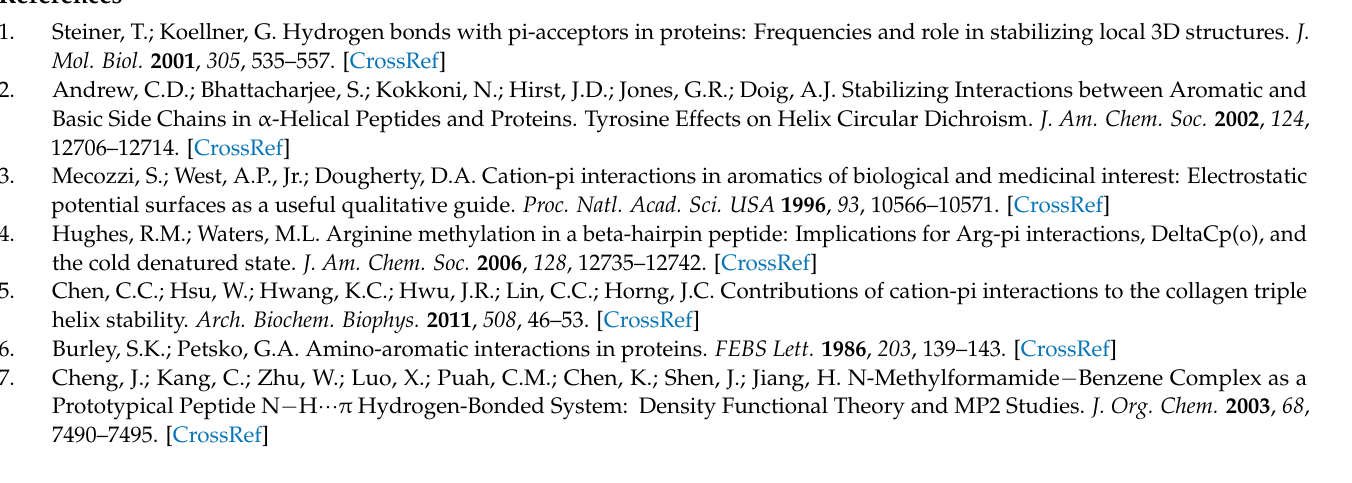
Table S1: Terms of interaction energy from SAPT2+3/aug-cc-pVQZ and MP2 methods; Table S2. Crystal statistics of crystal data collection and structure refinement one crystal was used for each structure; Figure S3: Molecular dynamics simulation of the collage-like peptide GPQGFO; Figure S4: Side chain interactions of Q-F pairs exposed on protein surface in the crystal structure of PDB ID:4OV4, 7ODC, and 3CK6; Figure S5: HPLC Chromatograms and Mass Spectrometry analysis of peptides; Figure S6: The electron density map of the Q-F